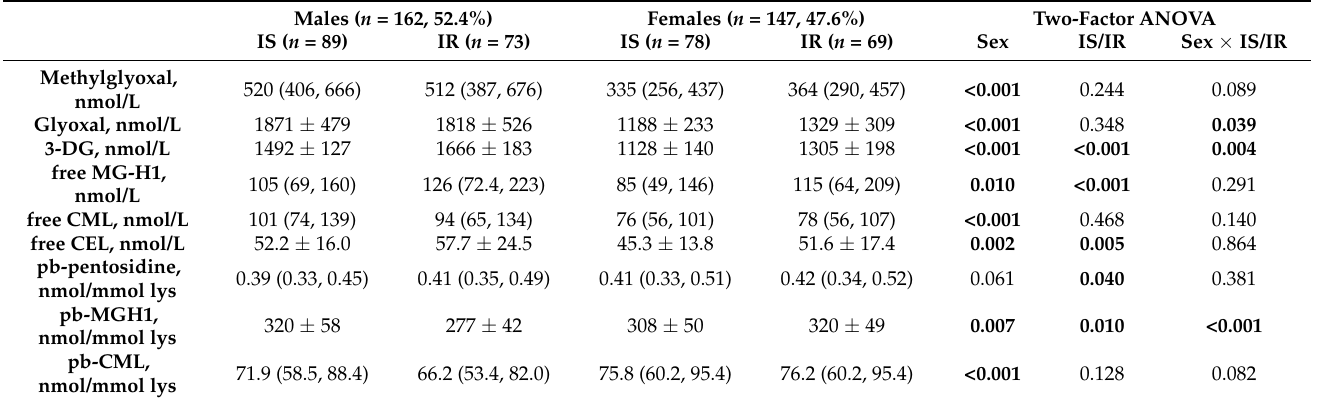
Table 2. Reactive dicarbonyls, advanced glycation end-products, soluble receptors for advanced glycation end-products, and soluble vascular adhesion protein levels in sera; urinary excretion of advanced glycation end-products and D-lactate; and fractional excretion of advanced glycation end-products in insulin-sensitive and insulin-resistant males and